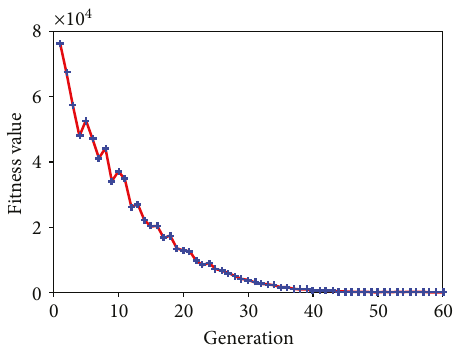
Figure 6: The fi tness value with genetic algebra of the variable span missile.